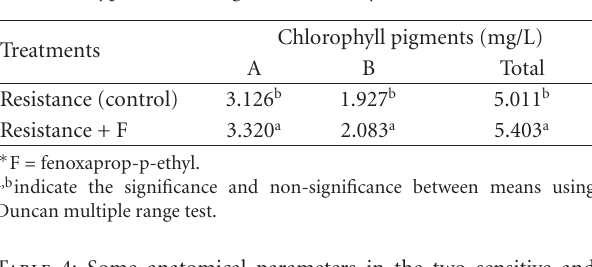
Table 3: Chlorophyll contents in resistant untreated and resistant treated biotypes of E. crus-galli after 21 days of treatment.